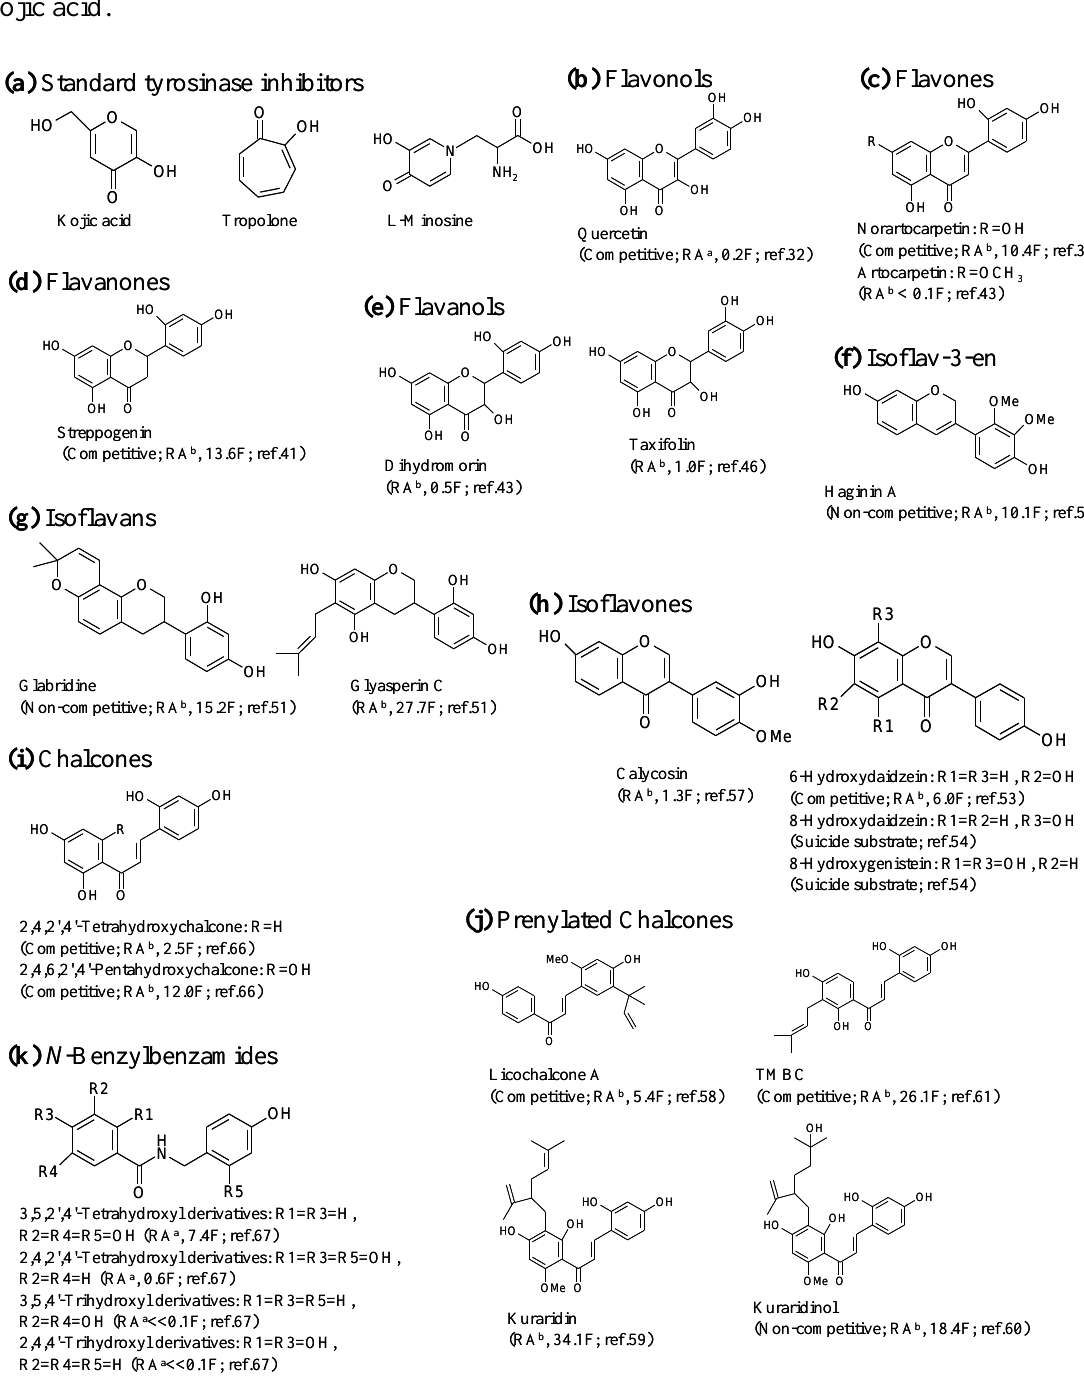
Figure 3. Chemical structures of selected tyrosinase inhibitors belonging to some standard ones (a), flavonoids (b-j) or N -benzylbenzamides analogs (k). RA a and RA b are the relative diphenolase and monophenolase inhibitory activity, respectively, against mushroom tyrosinase compared to the standard kojic acid, where 1.0F means one time activity of kojic acid.